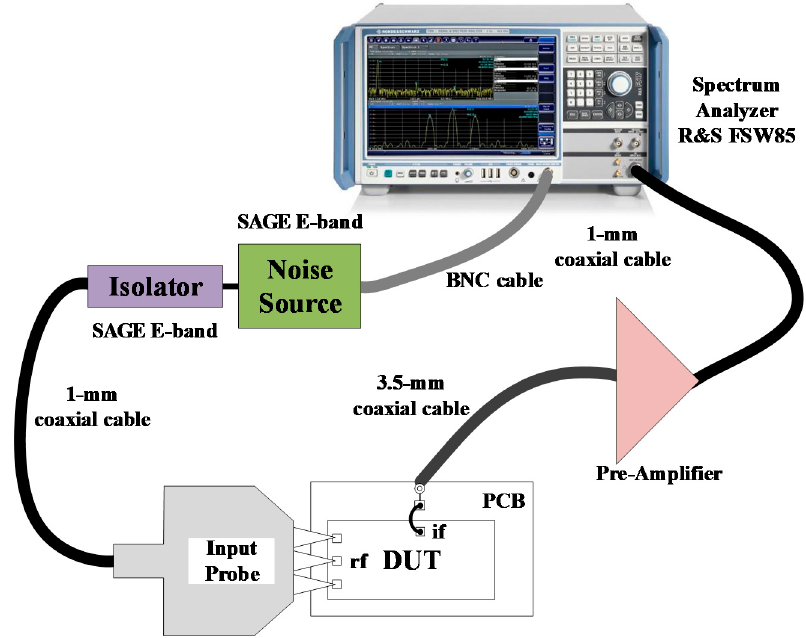
Figure 16. The NF measurement setup for the receiver.